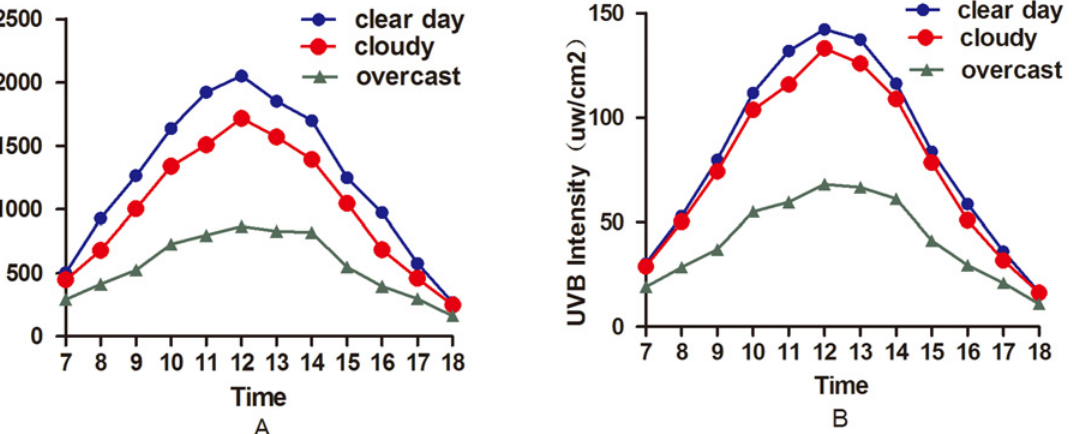
Fig 3. Changes in ultraviolet light intensity at different times and in three types of weather. Regardless of the weather, the UVA and UVB intensities were highest at 12:00 each day. There were significant differences in the UVA intensity among the three types of weather; the UVA and UVB intensities peaked on clear days and were lowest on overcast days.